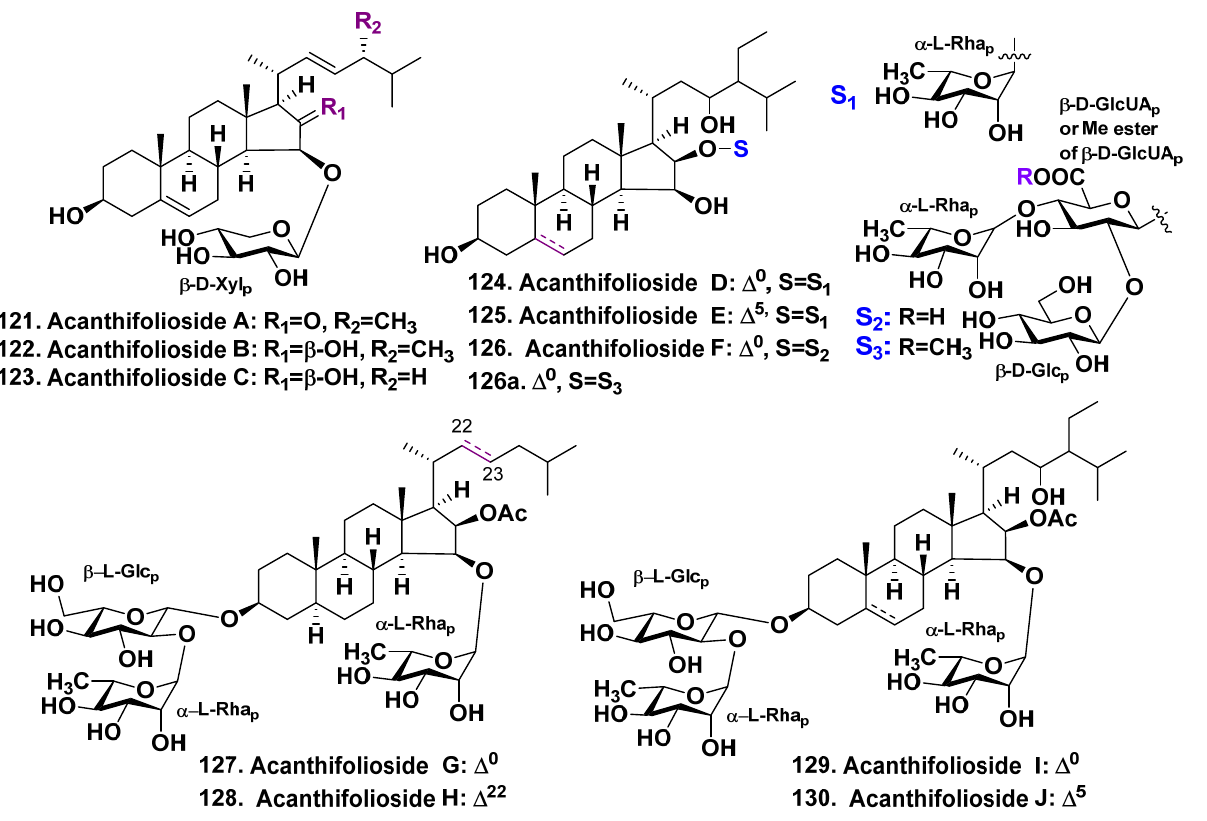
Figure 15. Acanthifoliosides 121 – 130 and methyl ester of acanthifolioside F ( 126a ) from Pandaros acanthifolium .